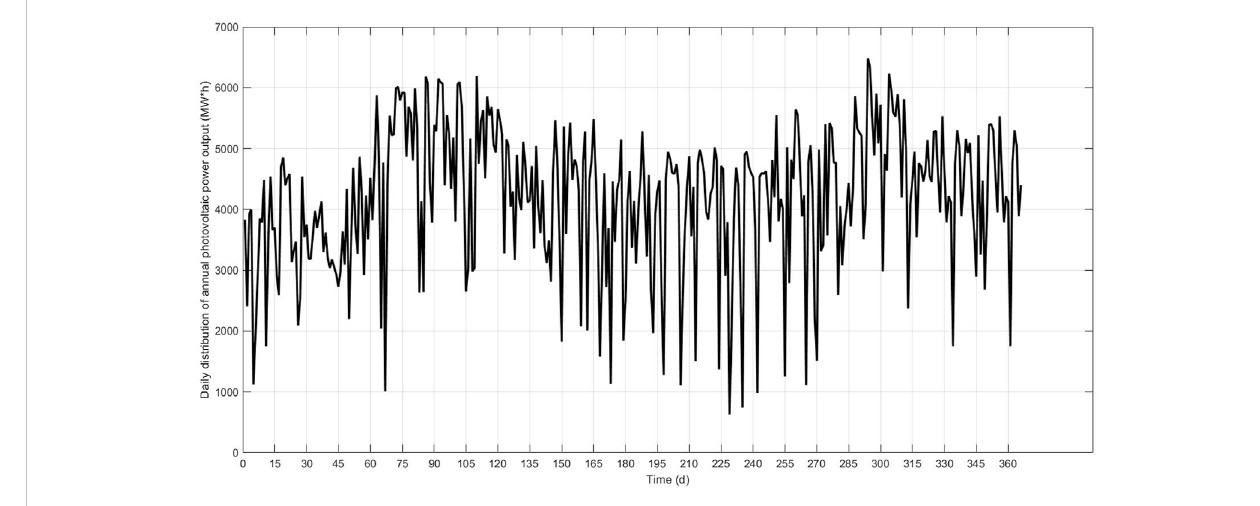
FIGURE 4 Daily distribution of photovoltaic power along a